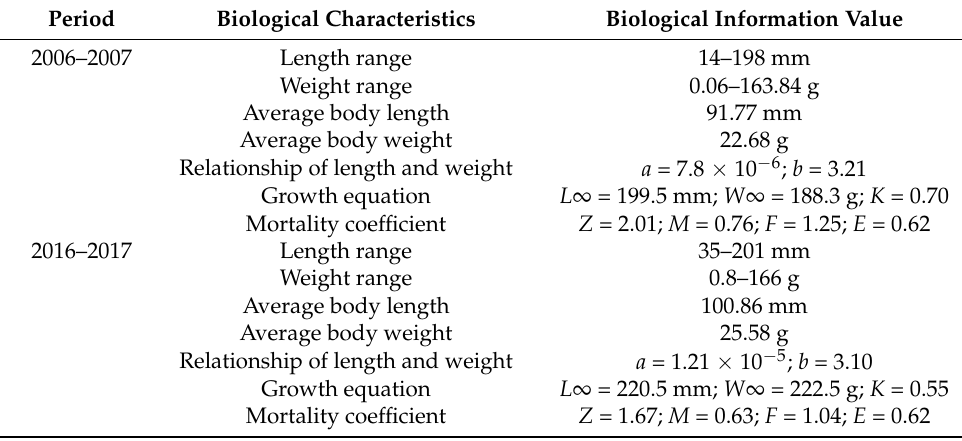
Table 1. Biological characteristics and biological information values from two periods.